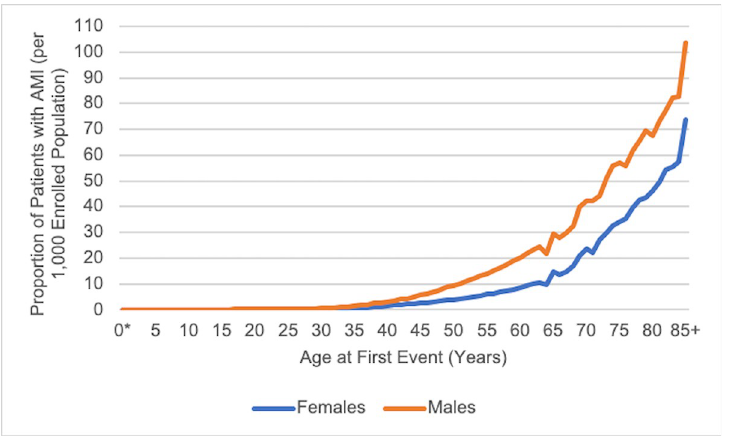
Fig 2. Proportion of patients with at least one diagnosis for AMI in any healthcare setting per 1,000 enrollees, by gender and age at first AMI diagnosis in the database (2014–2017). Abbreviation: AMI, acute myocardial infarction.